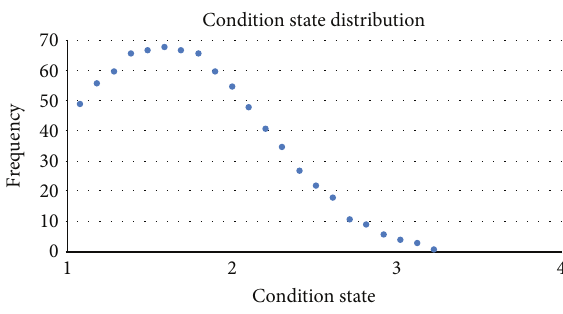
Figure 10: Distribution of condition state values generated for 20- year interval.